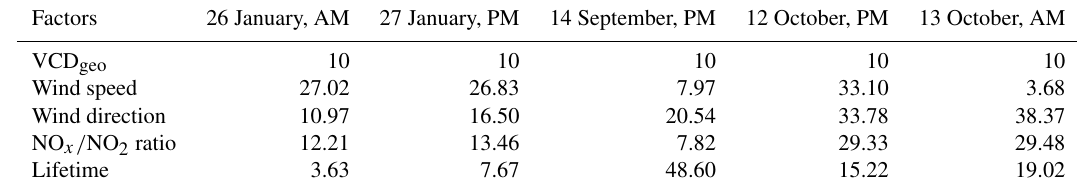
Table 3. Error contributions (%) of multiple factors to the uncertainties in estimated E NO